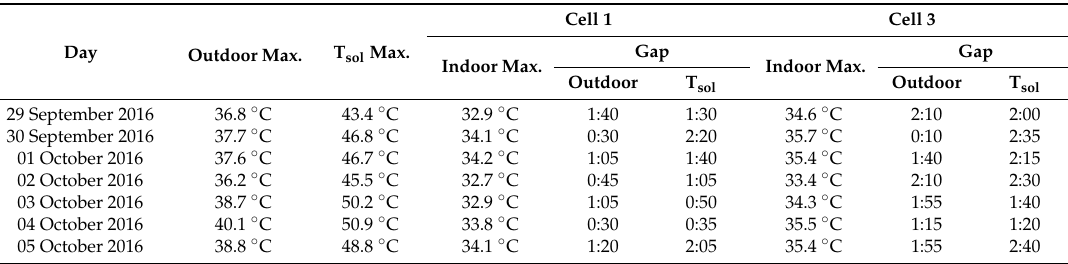
Table 10. Air ambient temperature in Cells 2 and 4.